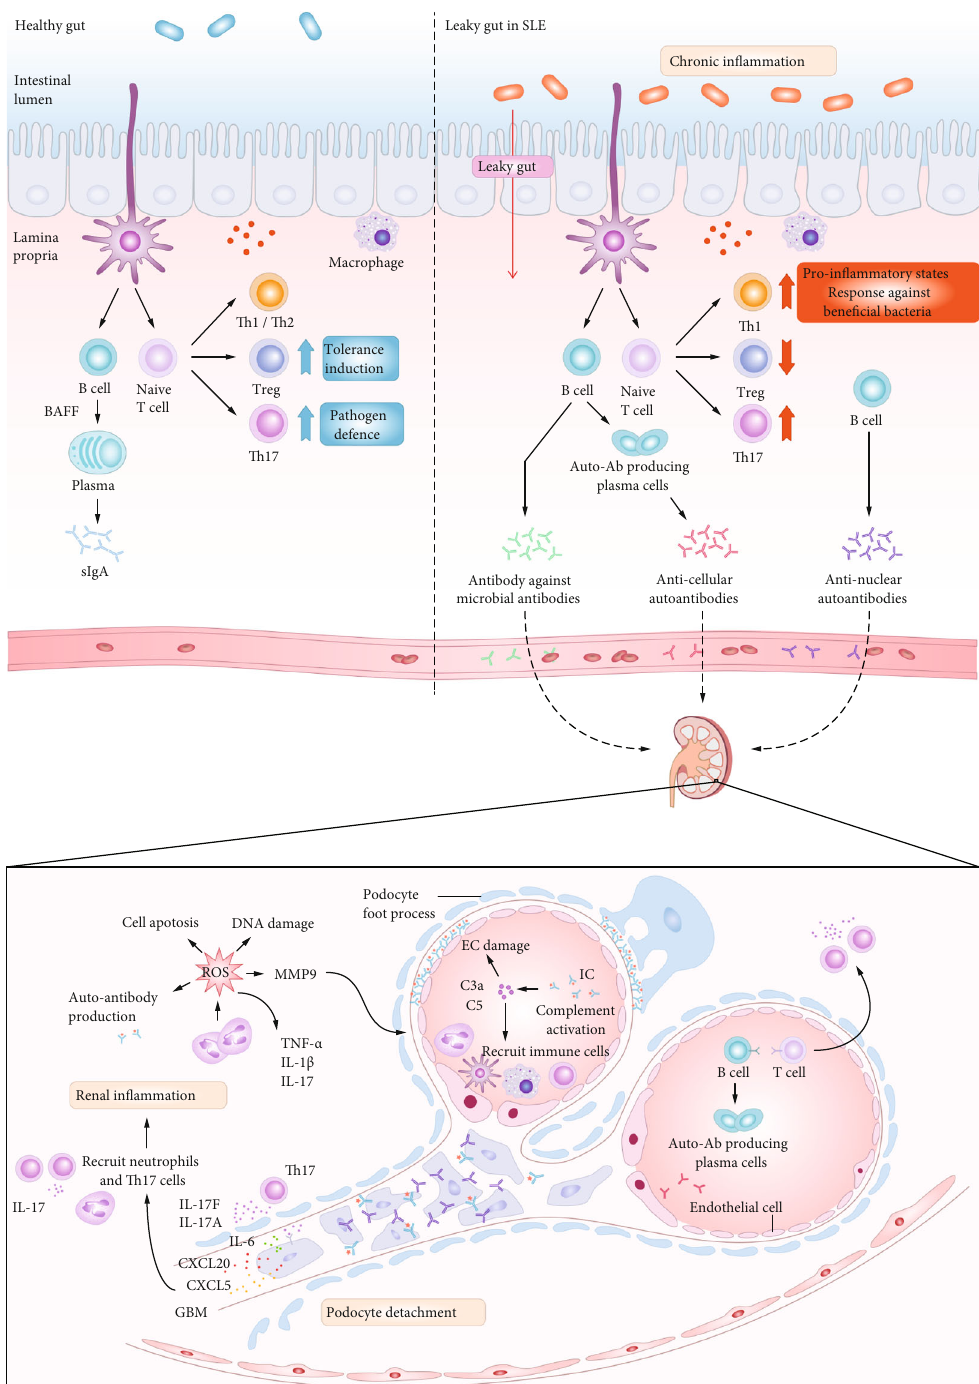
Figure 2: Correlation between intestinal microbiota and the incidence of lupus nephritis. Under the symbiotic condition, intestinal microorganisms can a ff ect gut tolerance, immunity, and sensitivity to in fl ammation through B cell maturation, Treg/Th17 ratio balance, and anti-in fl ammatory cytokine secretion. In SLE patients, the intestinal in fl ammatory atmosphere can induce B cells to release autoantibodies, resulting in an imbalance of the Treg/Th17 ratio, leading to intestinal tolerance disorders, beyond immune response and autoimmunity, and tissue/organ damage (such as lupus arthritis (LN)). A large number of autoantibodies and immune complexes are produced and enter the circulation. The deposition of autoantibodies and immune complexes in the glomeruli leads to the activation of complement components (e.g., C3a and C5), resulting in the endothelial cell or podocyte injury and recruitment of immune cells. In fi ltrated Th17 cells in the kidney secrete cytokines IL-17A and IL-17F, which activate mesangial cells and tubular epithelial cells to produce CXCL5 and CCL20, then recruit more Th17 cells and neutrophils through CCR6 and CXCR2, respectively. At the same time, ROS produced by in fi ltration of immune cells can lead to further renal in fl ammation and tissue